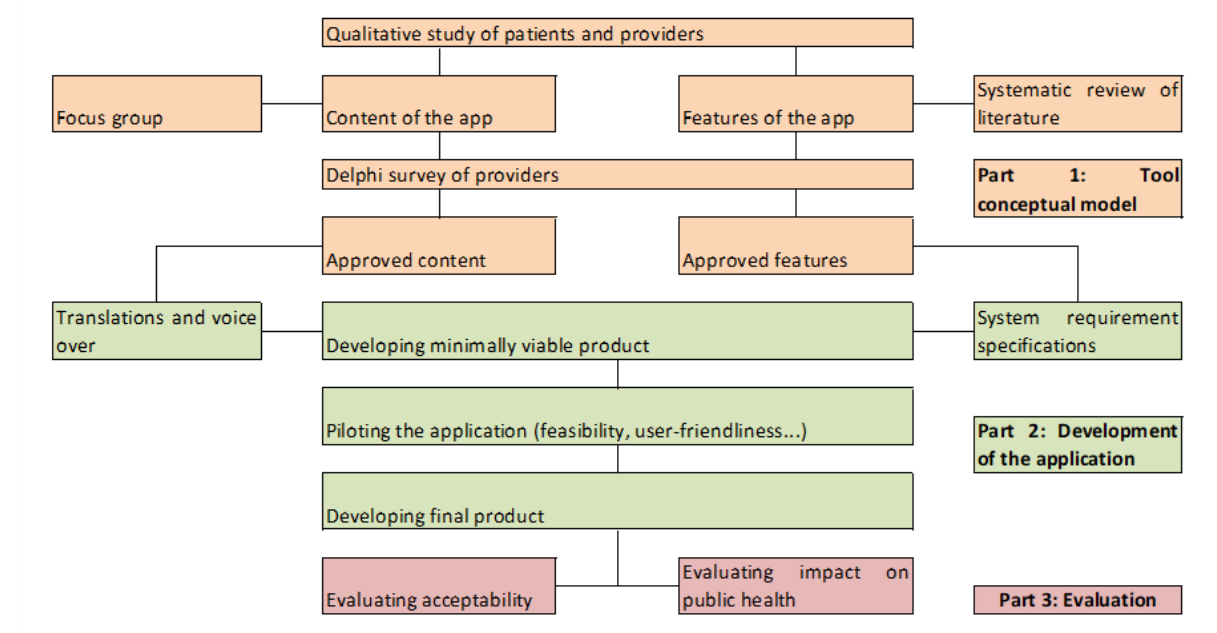
Figure 1. Overview of the steps in the Apidé